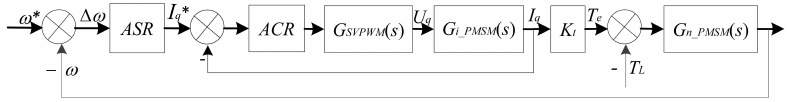
Figure 1. The transfer function block diagram of PMSM sensorless system.